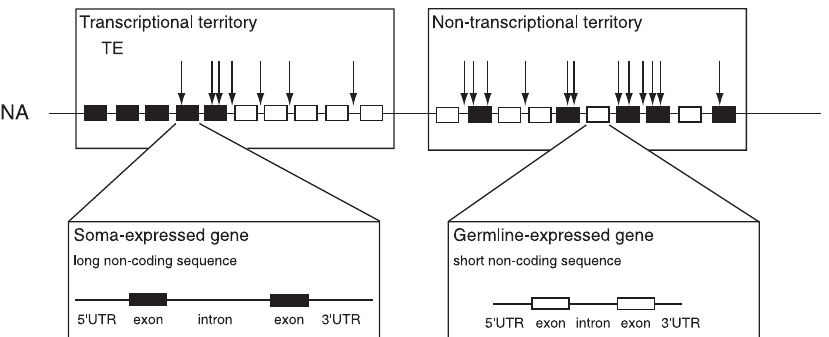
Figure 5. Schematic Representation of TE Dynamics in the Euchromatin of D. melanogaster This figure illustrates the distribution of TEs in and between germline-expressed and soma-expressed genes (in white and black, respectively) within and outside transcriptional territories.